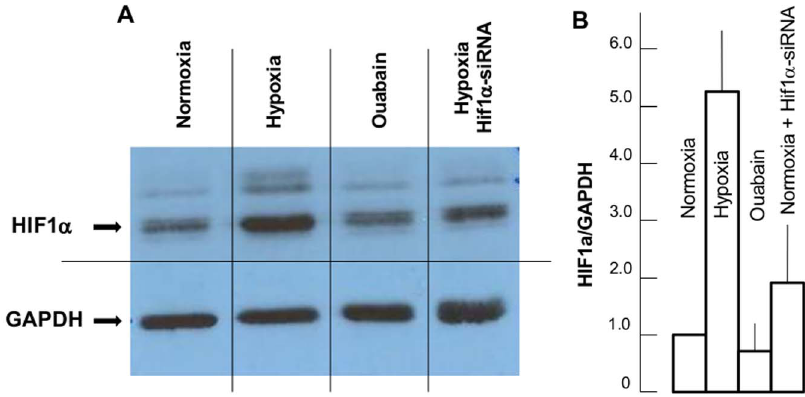
Figure 6. A . Representative Western blots of HIF-1 a and GAPDH in RASMC subjected to 24-hr incubation under control conditions (normoxia), hypoxia/glucose deprivation, 3 mM ouabain or hypoxia/glucose deprivation in cells transfected with Hif-1 a siRNA. B . Effect of hypoxia/glucose deprivation and ouabain on relative content of HIF-1 a protein in RASMC. The HIF-1 a /GAPDH ratio in control conditions was taken as 1.00. Data obtained in 3 independent experiments are reported as means 6 S.E.